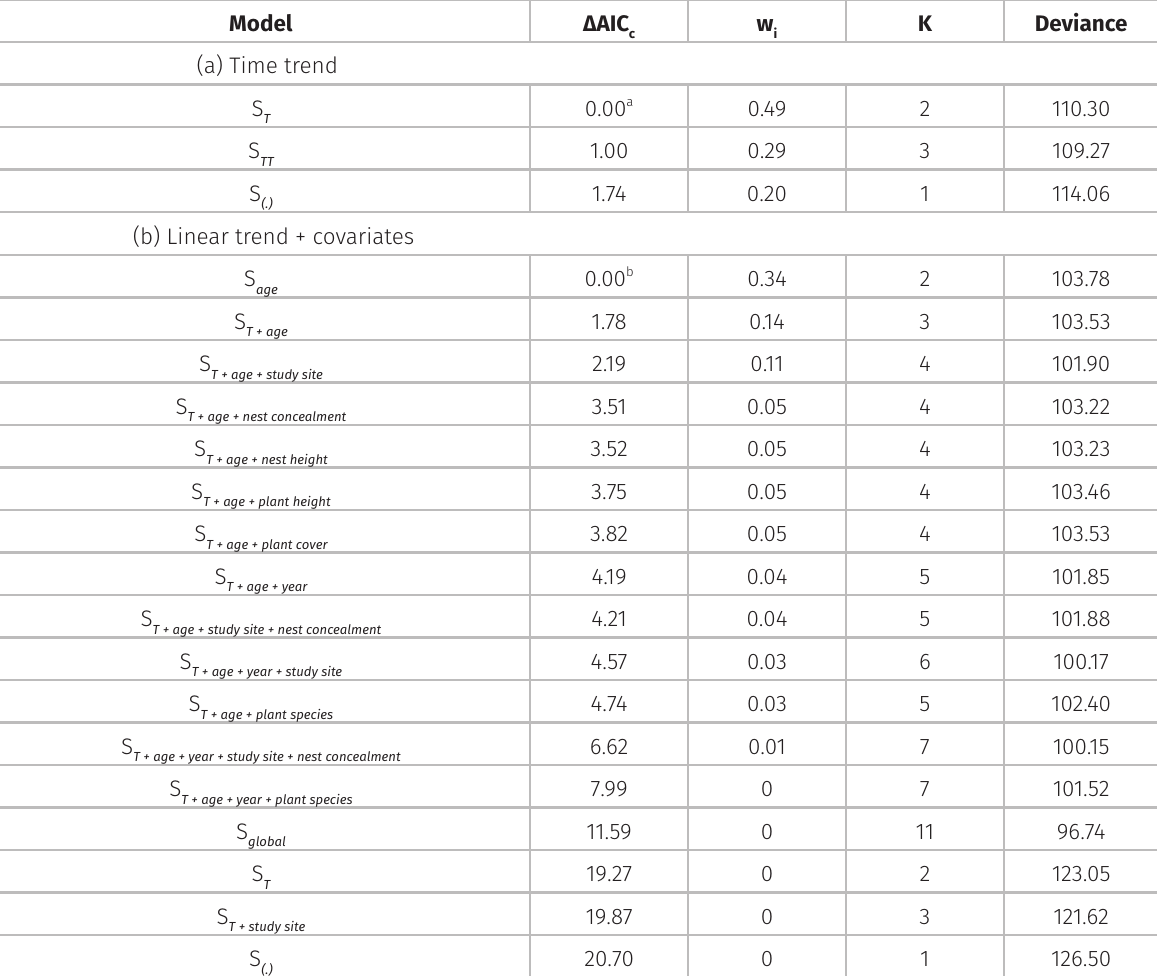
Table I. Model for DSR indicating (a) time trend and (b) the determinants of daily survival for nests of Tawny- bellied Seedeaters Sporophila hypoxantha in southern Brazilian grasslands, over three breeding seasons (2007- 2010). AIC represents Akaike´s Information Criterion corrected for small sample sizes. We excluded models with performance worse than the null model. a AIC and the top model; K = number of parameters; w (.) = null model. Notations follow Dinsmore et al.